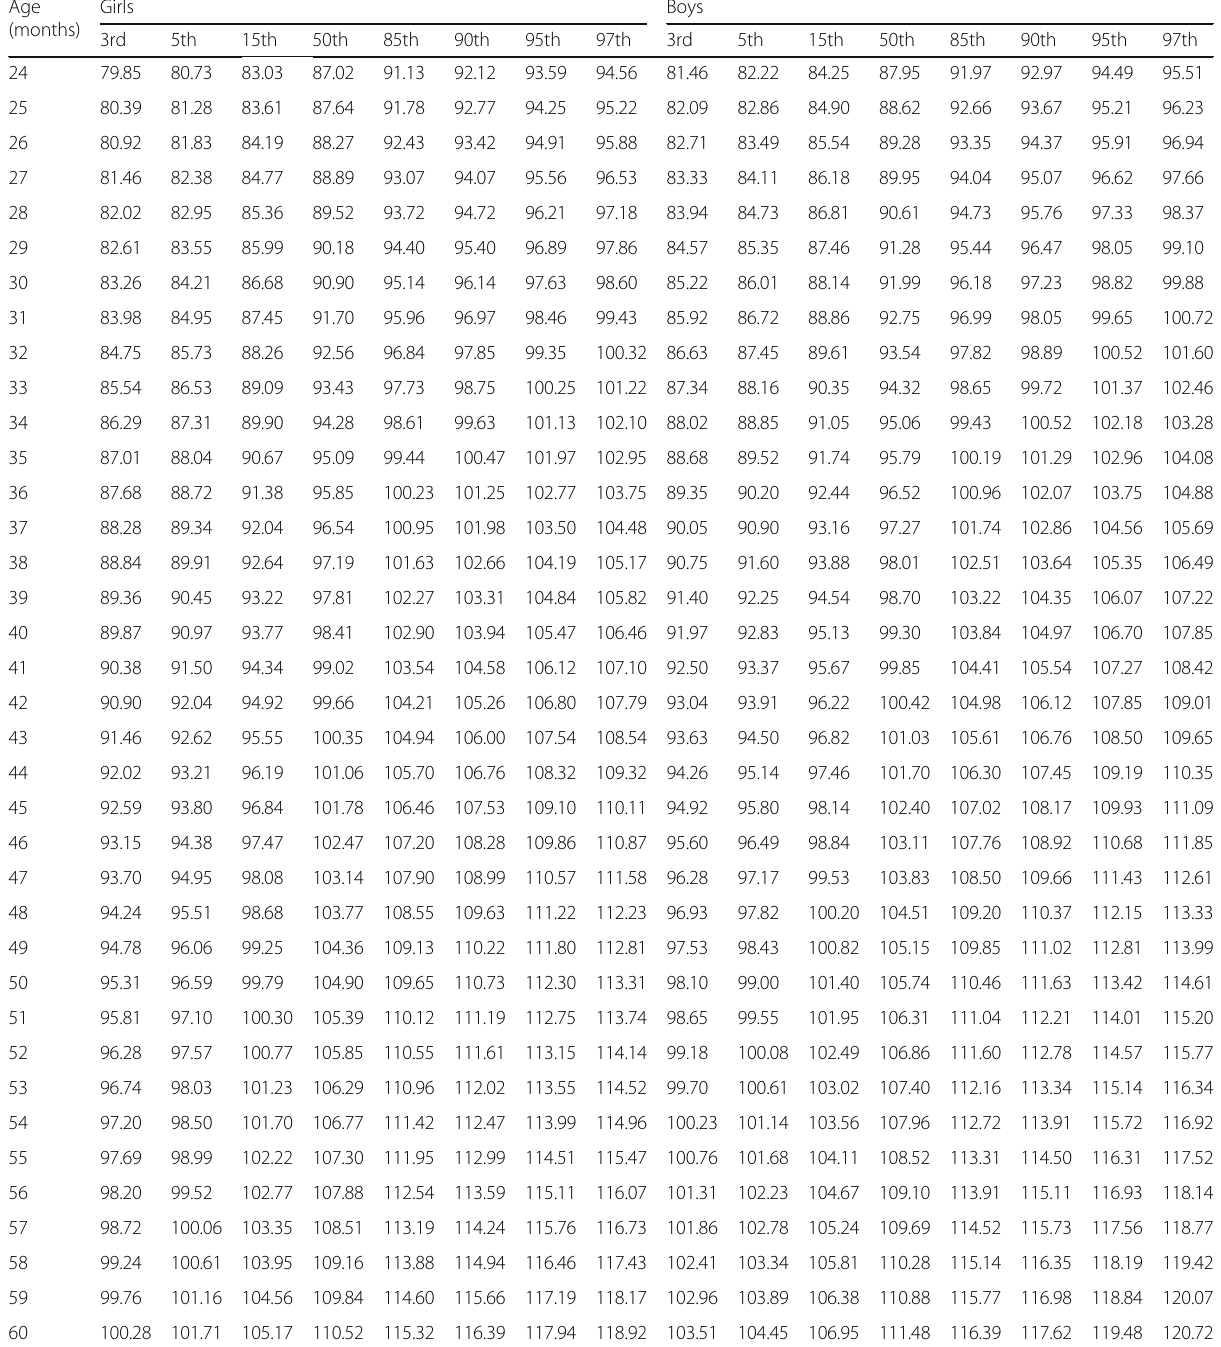
Table 2 Percentiles of height (cm)-for-age for girls and boys, age in months Age Girls (months)